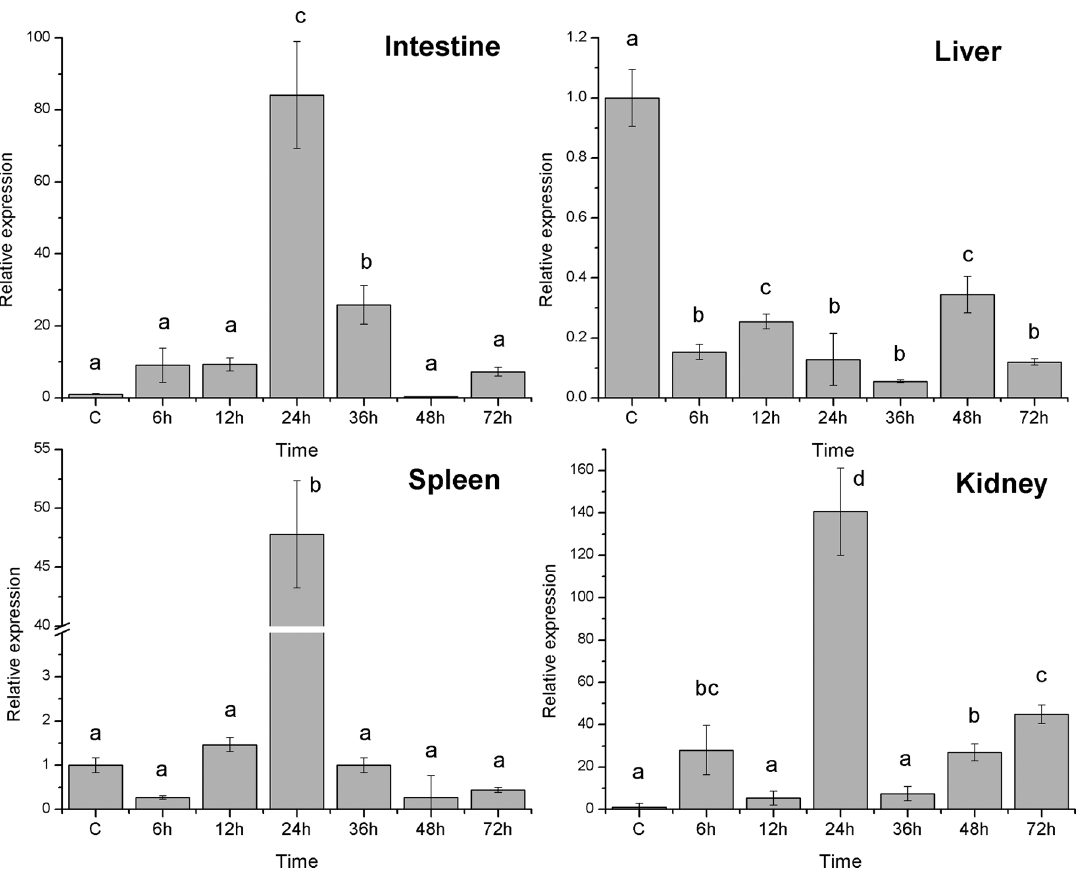
Figure 4. Expression of hepcidin gene in four tissues after injection with V.anguillarum sampled at six time point. Values with the same superscript are not significantly different ( P . 0.05).